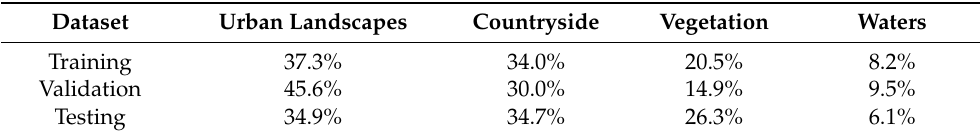
Table 3. Percentage of images per category and per subset.